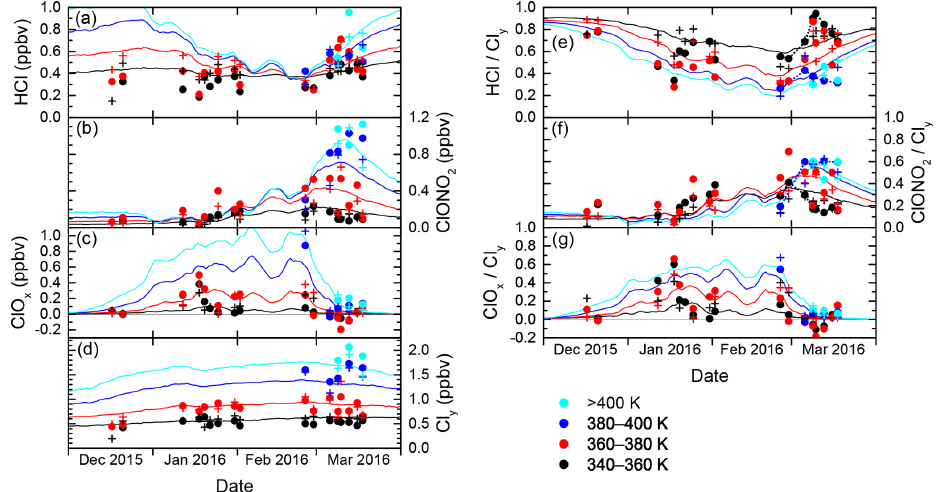
Figure 9. Similar to Figs. 6 and 8. In addition, lines represent whole vortex model